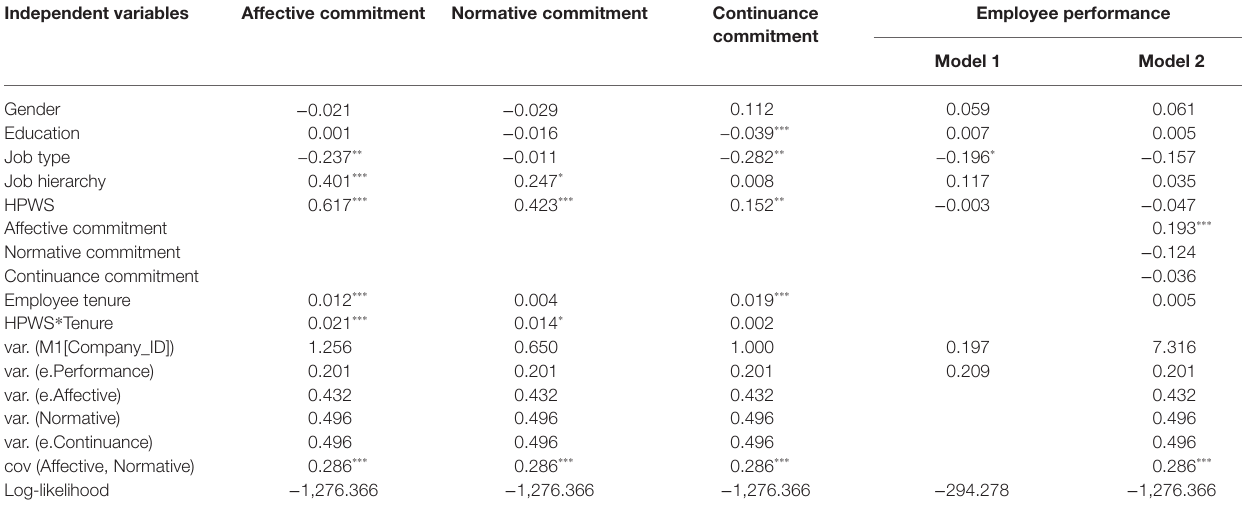
TABLE 3 | Multilevel structural equation modeling